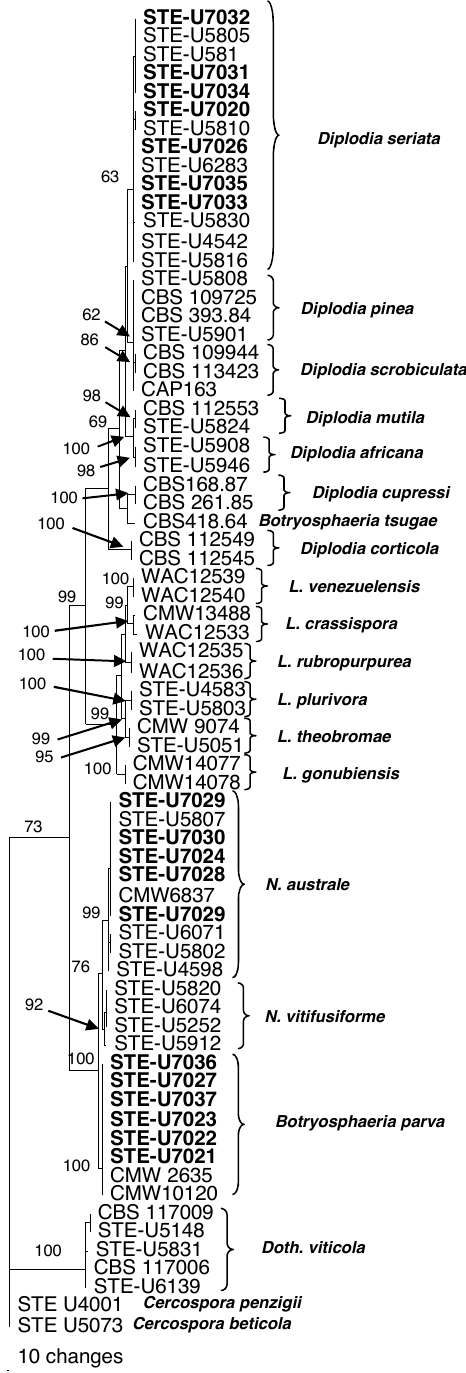
Figure 3. One of 70 most parsimonious trees obtained from heuristic searches of the combined EF and ITS sequences (length: 759 steps; CI: 0.735; RI: 0.950; RC: 0.698) of Botryosphaeriaceae isolates. Bootstrap support values above 60% are shown above the nodes. The outgroups used were Cercospora penzigii and Cercospora beticola . Isolates in bold print are isolates from this